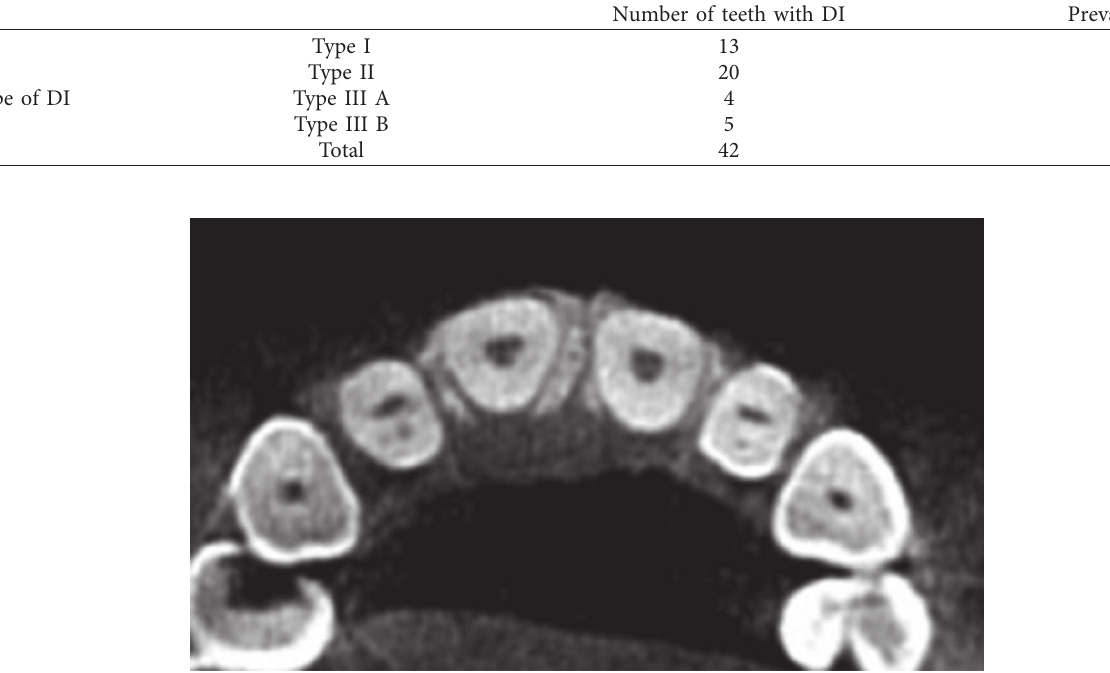
Figure 1: Example of bilateral invagination in lateral maxillary teeth (axial plane).